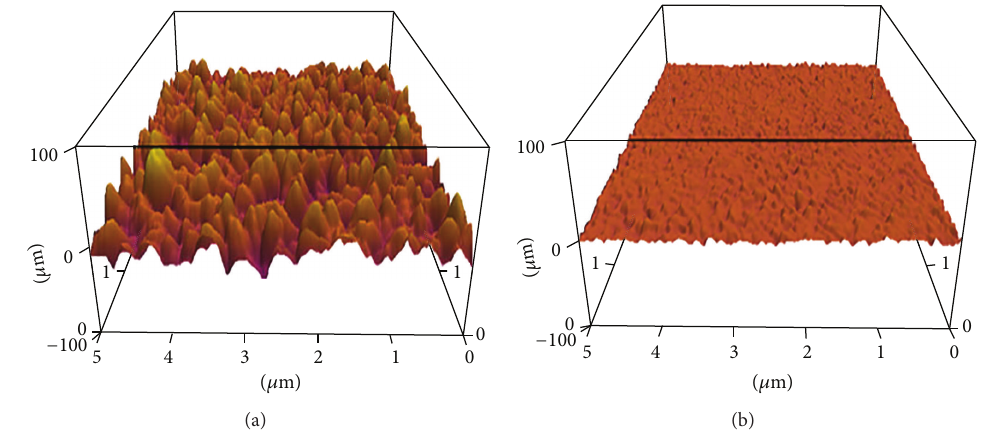
Figure 3: AFM micrographs of the ZnO-based thin films.